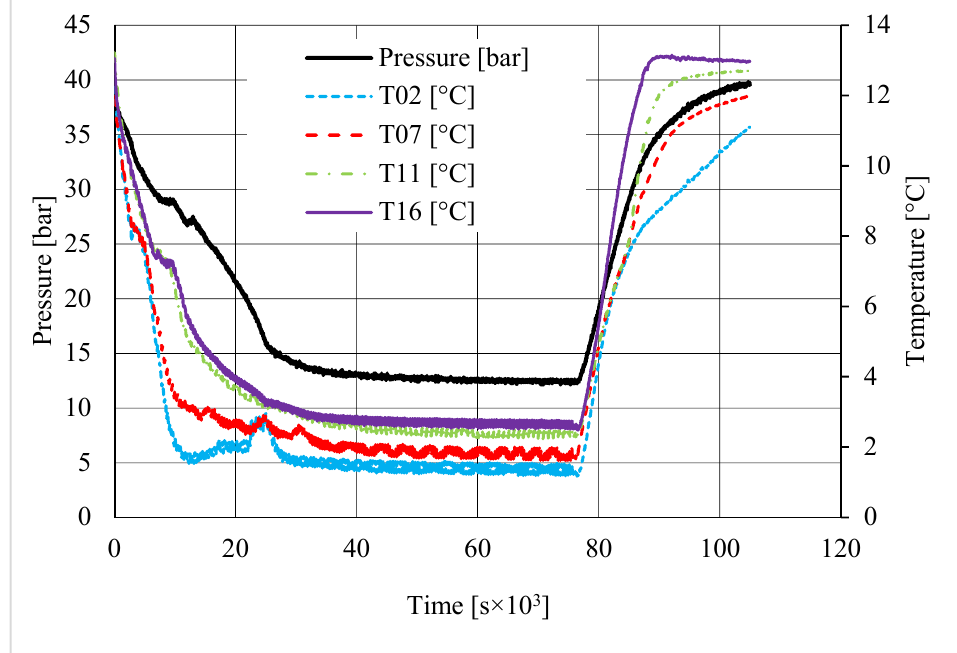
Figure 20. Pressure and temperature trend over time, measured for carbon dioxide hydrate formation in the presence of 30.66 wt.% CuSn12 powder.